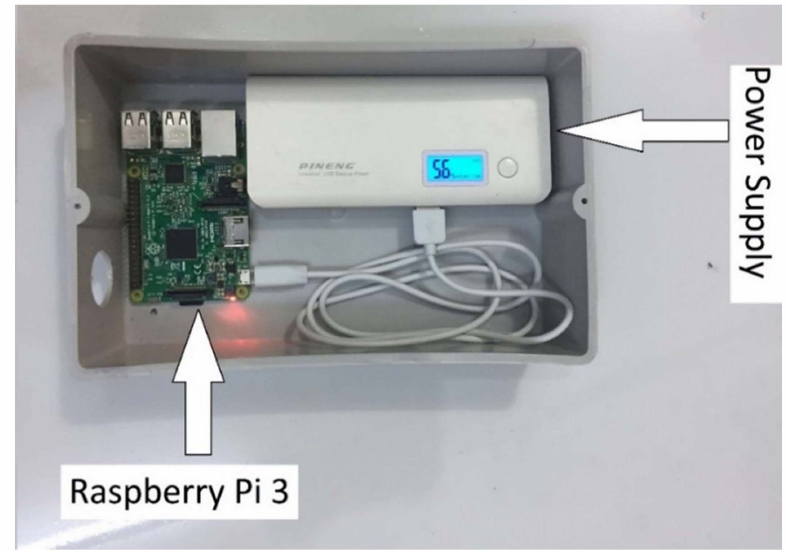
Figure 9. Base Station Unit structure.